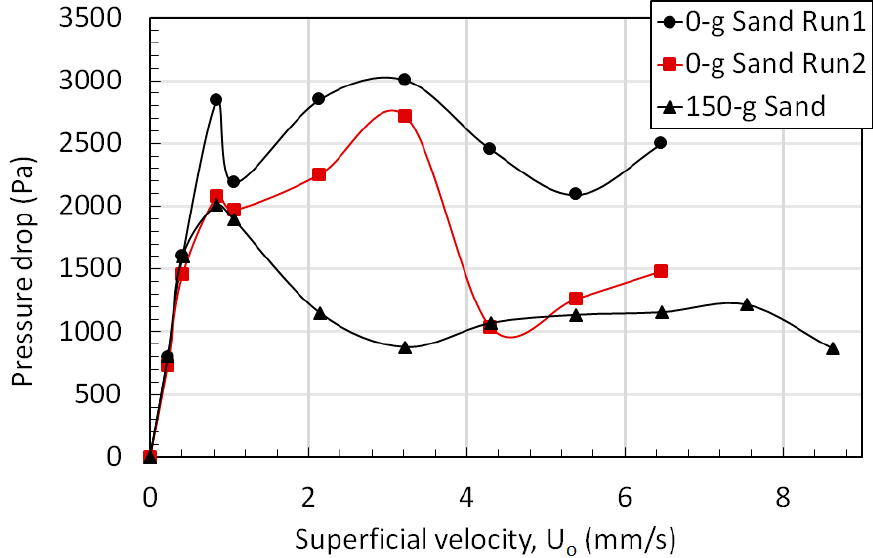
Figure 8. Effect of the velocity and the particle-mixing on the pressure drop profiles of the bed of calcium hydroxide powder using nitrogen gas ambient conditions.